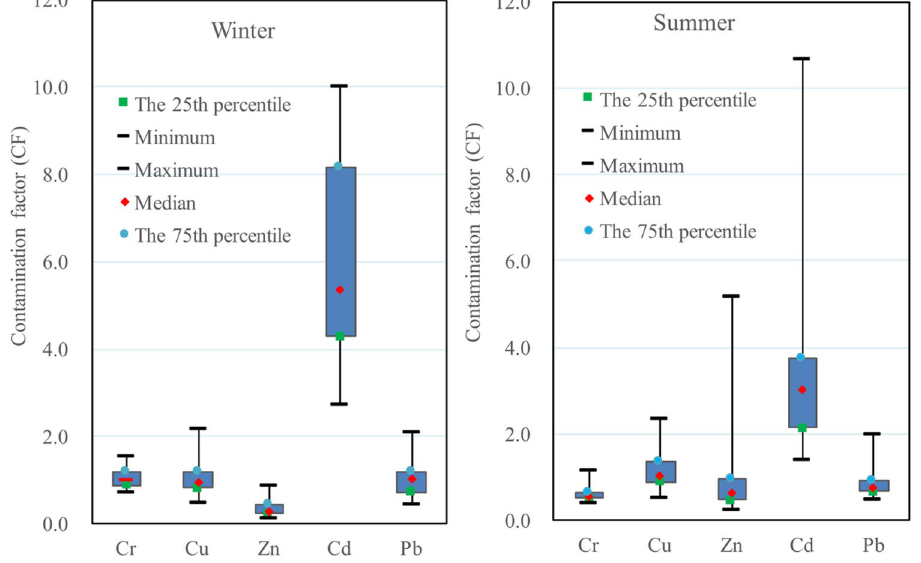
Fig. 1 Contamination factor of Cd, Cu, Cr, Pb and Zn in the surface